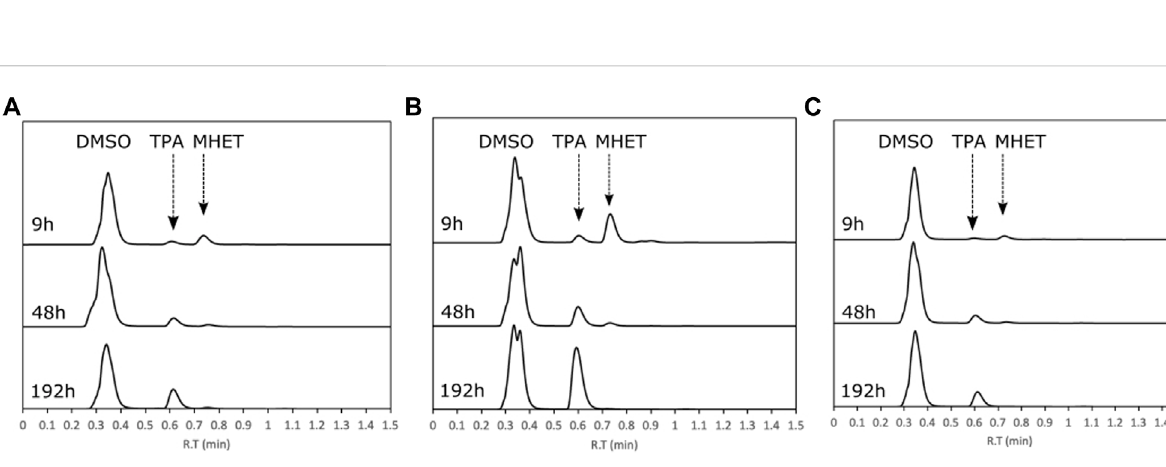
FIGURE 3 Analysis of HiCut depolymerization products by HPLC. Chromatograms of samples taken after 9, 48, and 192 h of reaction from powder of (A) PET, (B) Akestra TM 90, and (C) Akestra TM